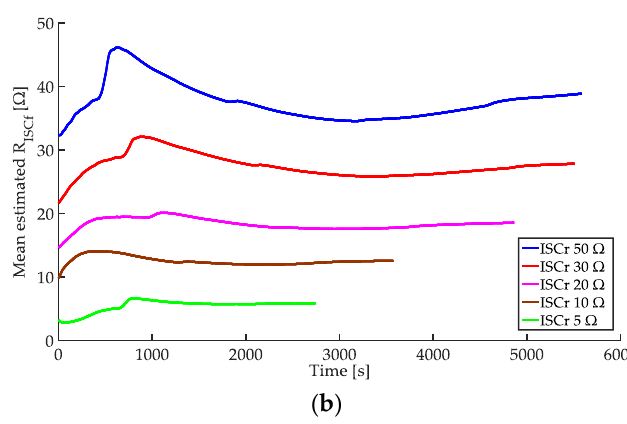
Figure 12. 𝑅 𝐼𝑆𝐶𝑓 ̅̅̅̅̅̅̅ in the experiment with cell B with ISCr 50, 30, 20, 10 and 5 Ω: ( a ) DST 3 A; ( b ) UDDS Figure 12. R ISCf in the experiment with cell B with ISCr 50, 30, 20, 10 and 5 Ω : ( a ) DST 3 A; ( b ) UDDS 3 A. 3 A. Table 6. Relative error (%) of the final value of R ISCf depending on the ISCr faults in the experiment with cell